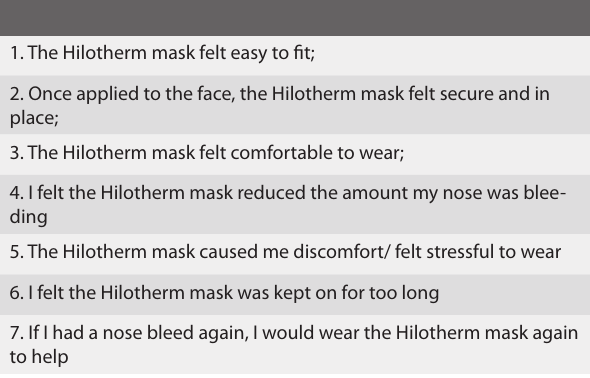
Table 2. Post Hilotherapy Questionnaire.